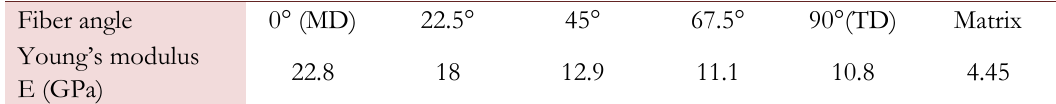
Table 2: Young’s modulus for various fiber angles.